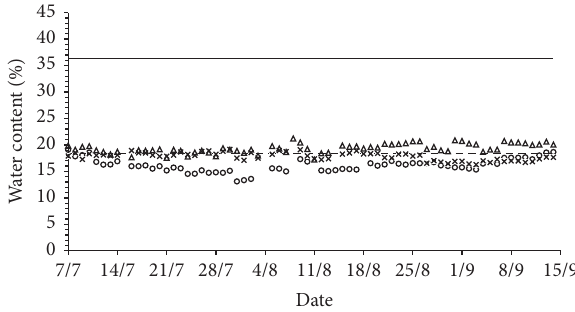
+Δ𝜃 −Δ𝜃 ) solid and ( 𝜃 ) op op op op